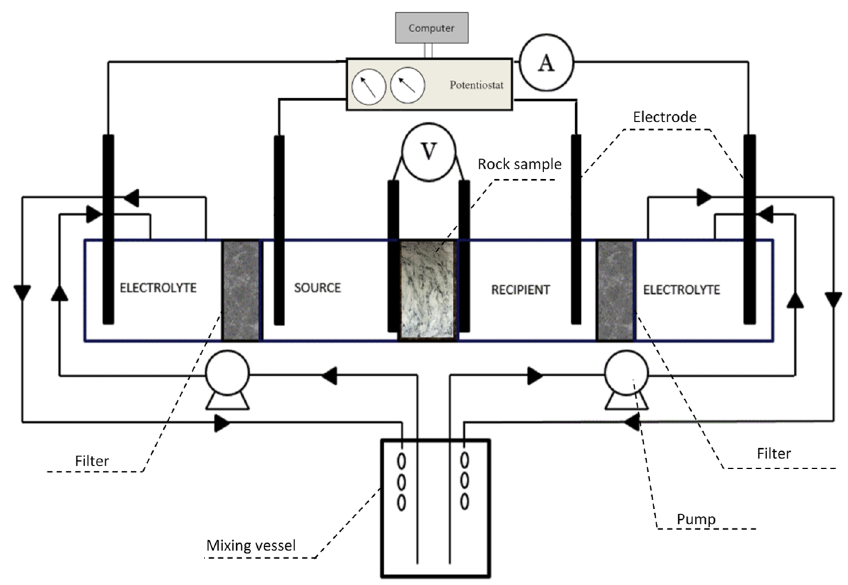
Figure 2. Schematic figure of the electromigration device run with Grimsel granodiorite. A potentio- stat was introduced in the modified device to improve the stability of the whole